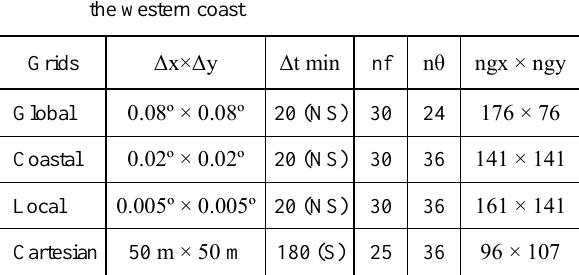
Table 1. Characteristics of the computational grids used in the case study considered for the system focusing towards the western coast